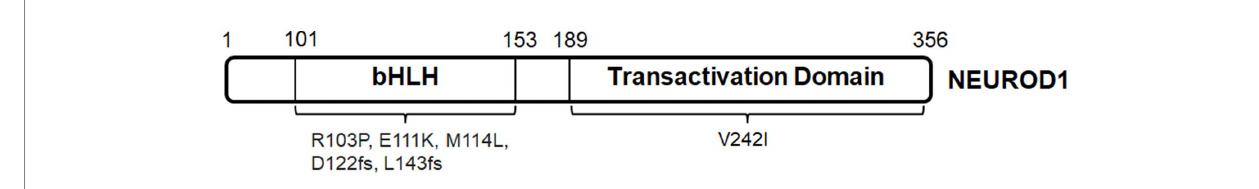
FIGURE 3 NEUROD1 protein domains and associated